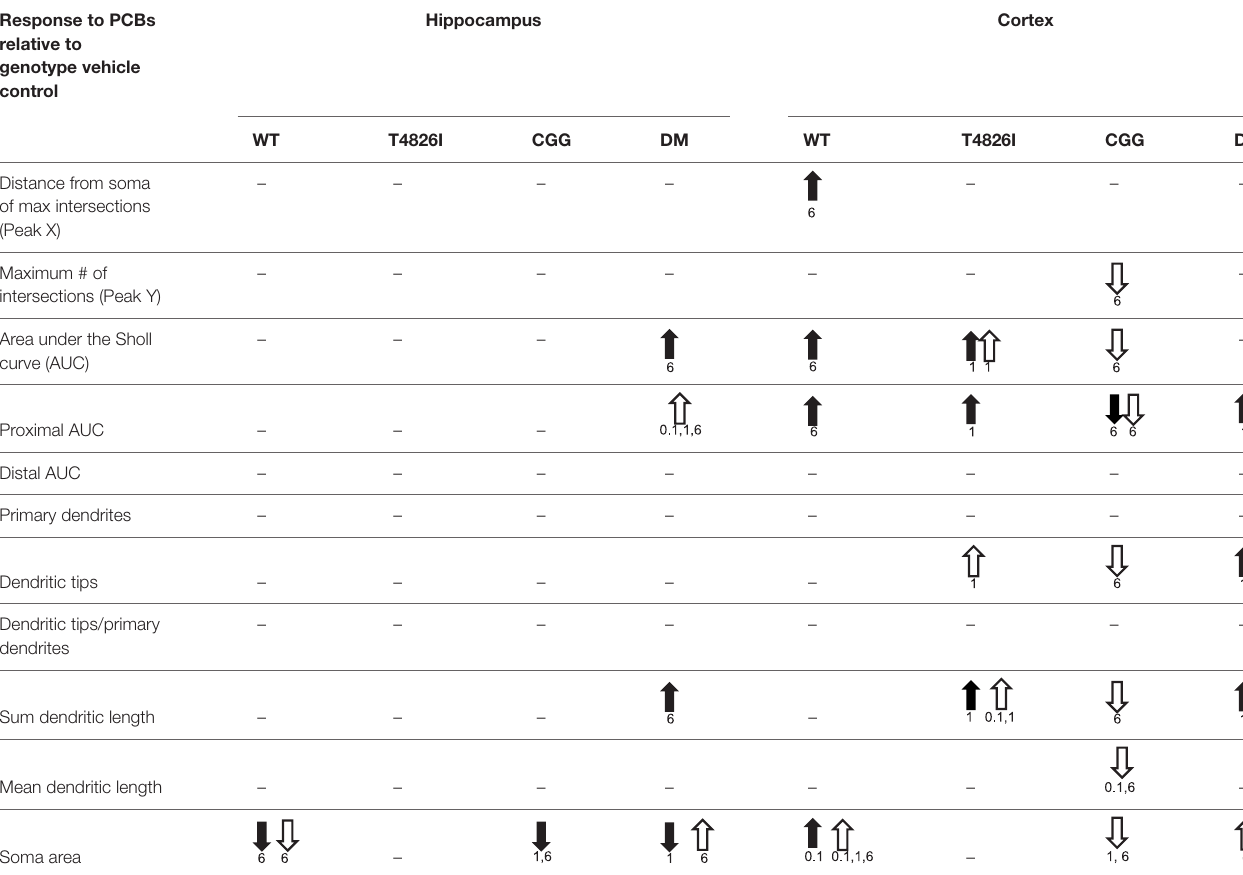
TABLE 3 | Summary of PCB effects on neuron morphology within each sex and genotype. Response to PCBs relative